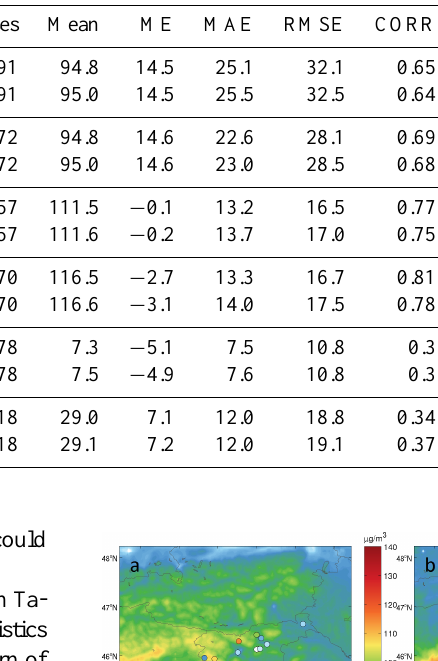
Table 3. Domain-wide performance statistics for 1-day and 2-day forecasts (in µgm − 3 ). Results for all hourly (hour), 8h averages (8h), 8h daily maximum (8h max), daily maximum (max) and daily average (day) concentrations are shown.